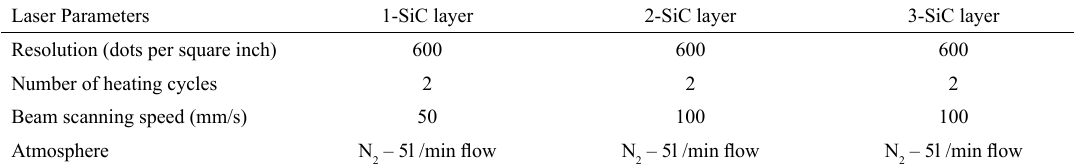
Table 1. Laser cladding parameters.